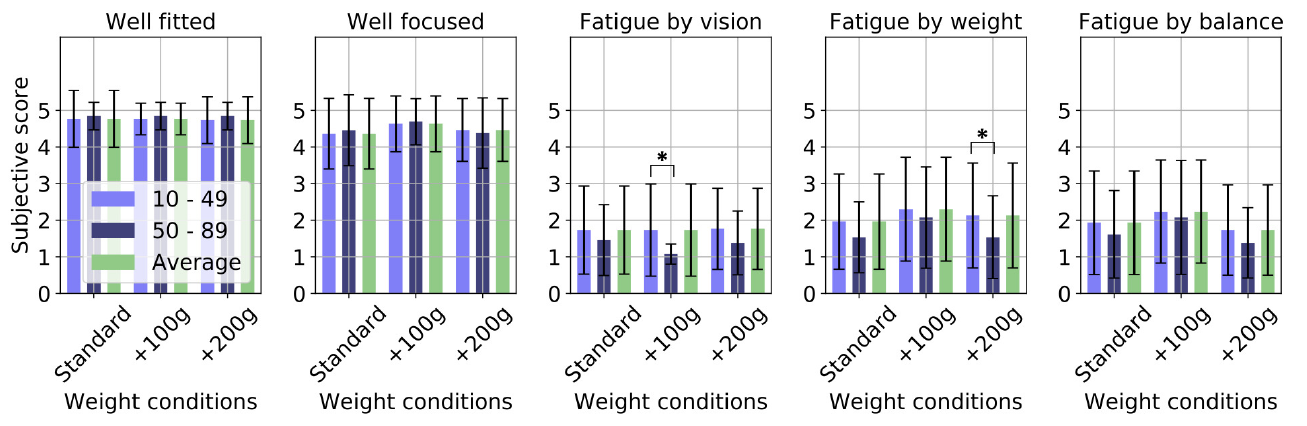
Figure 8. Questionnaire results for male participants in the “rear” group. The results of Q1 to Q5 are shown from left to right. (*: p <